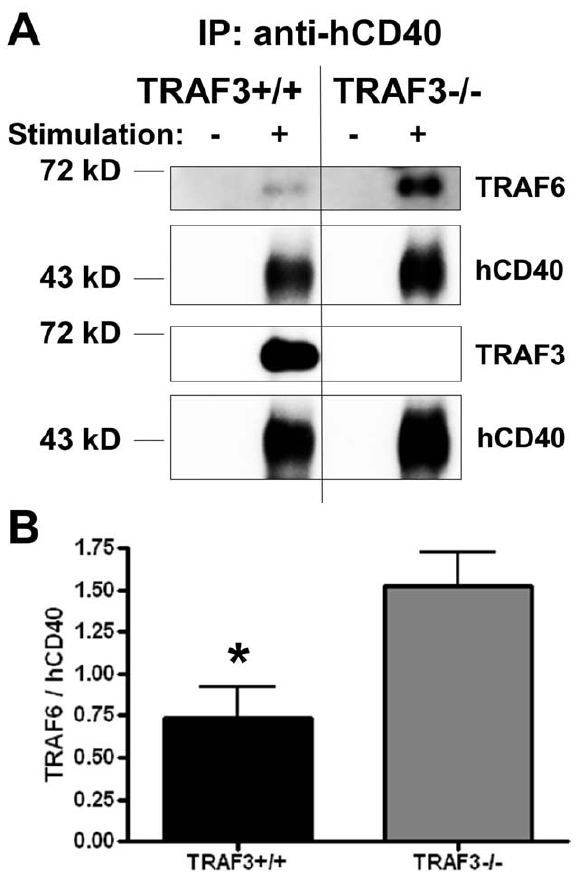
Figure 6. Association of TRAF6 with CD40 in the presence or absence of TRAF3. A) CH12.TRAF3 + / + or CH12.TRAF3 2 / 2 mouse B cells expressing hCD40 were stimulated with control ( 2 ) or anti-hCD40 ( + ) Ab-coated beads for 10 min. hCD40 was immunoprecipitated using the same beads. B) Quantitation by luminescence imaging of the results of 3 independent experiments, mean values 6 SEM. *p ,